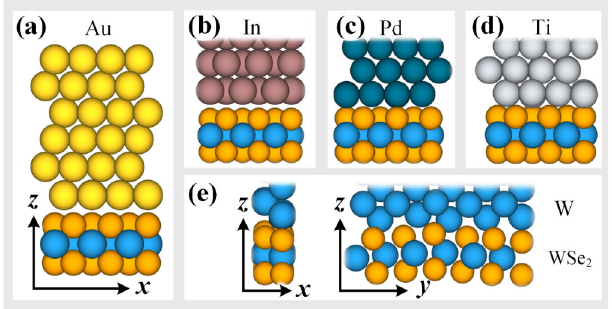
FIG. 9. Optimized geometries of top contacts to WSe 2 : (a) Au-WSe 2 , (b) In-WSe 2 , (c) Pd-WSe 2 , (d) Ti-WSe 2 , (e) W-WSe 2 (in different